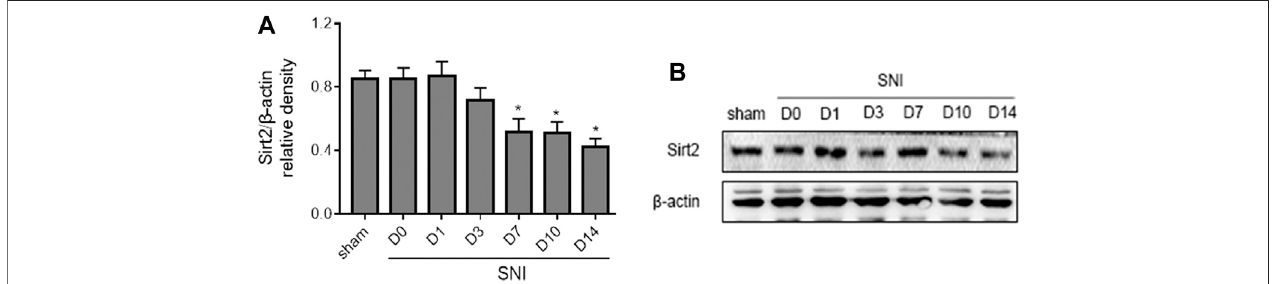
FIGURE6| Thetimecourse ofchangesinexpressionofSirt2inthespinalcordinSNIrats. Shamratsservedascontrol.Values areexpressed asmean ± SE(n (cid:1) 5 for each group). * p < 0.05 vs sham or baseline (day 0).